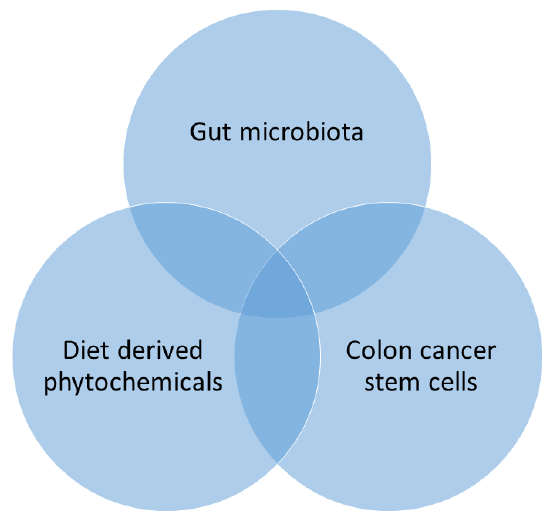
Figure 6. Triangular relationship between phytochemicals, gut microbiome, and cancer stem cells